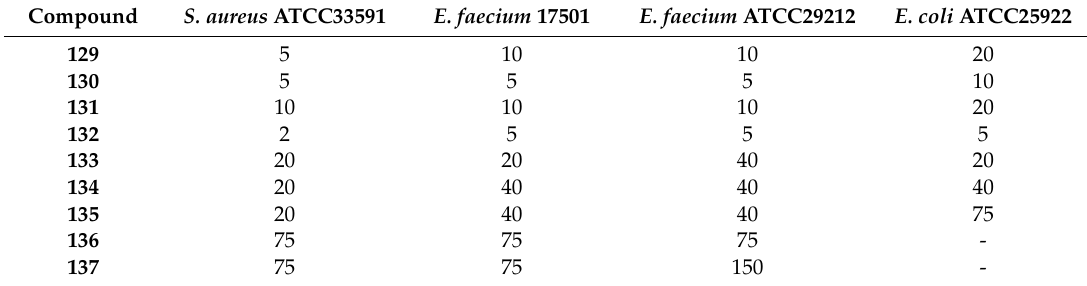
Table 23. MIC values for compounds 129 – 137 against the S. aureus ATCC33591 (resistant to methicillin), E. faecium 17501 (vancomycin-resistant clinical isolate), E. faecium ATCC29212, and E. coli ATCC25922 bacterial strains, expressed in µ M.